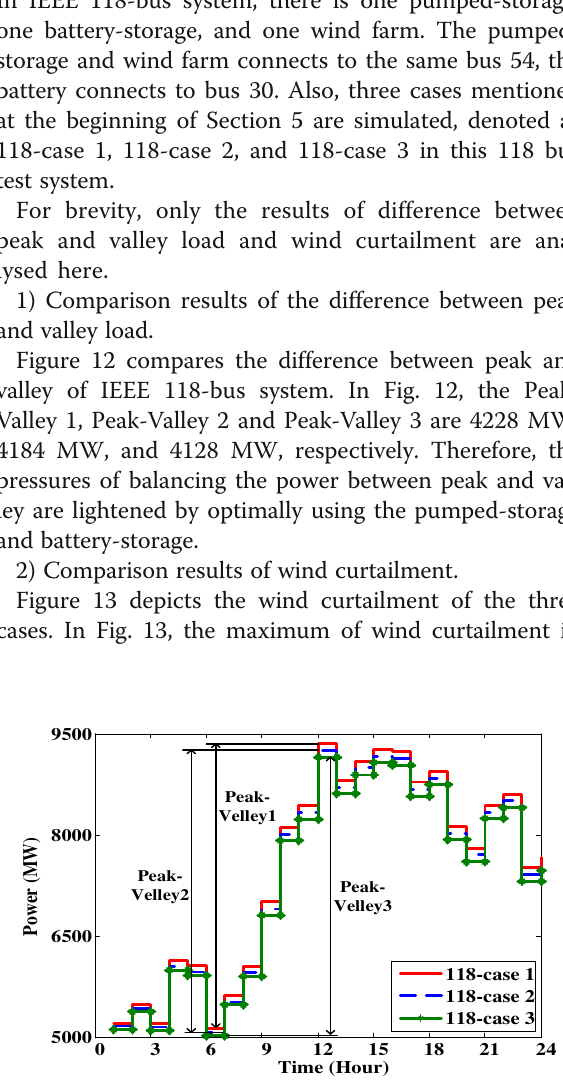
Fig. 12 Comparisons of difference of peak to valley of IEEE 118-bus